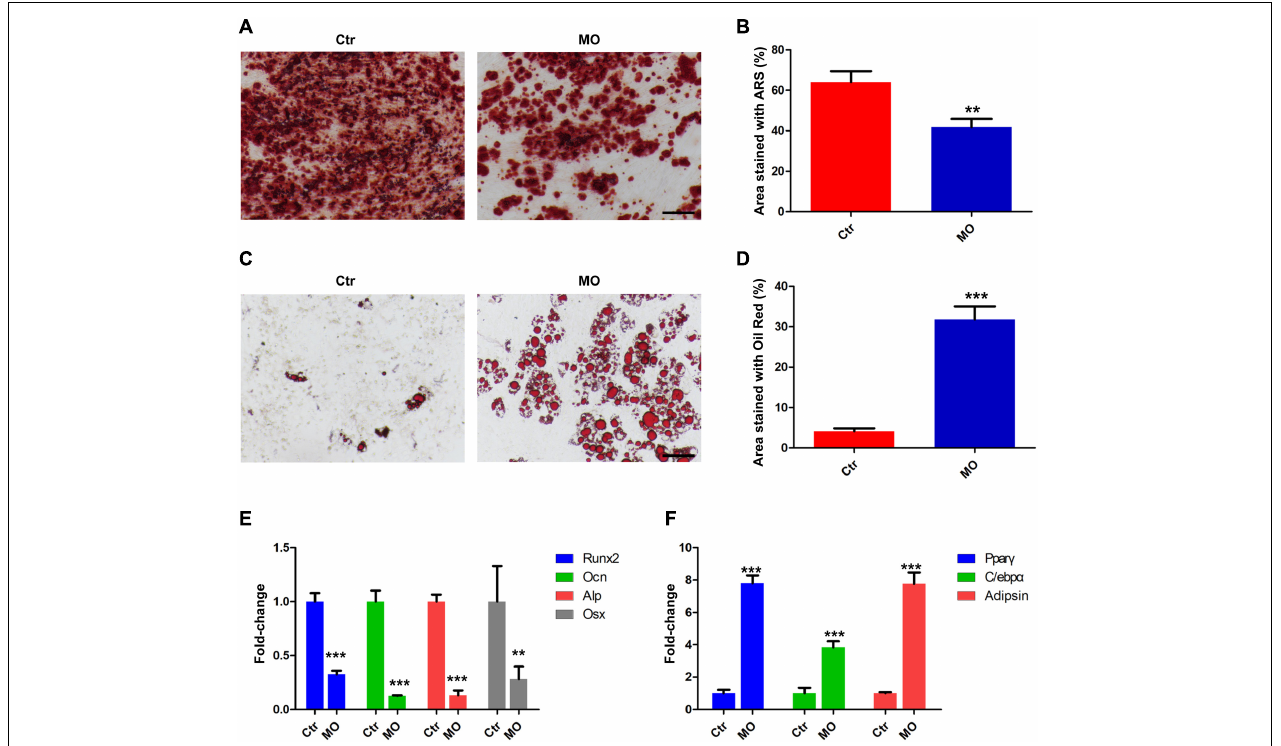
FIGURE 2 | The effects of INTS7 on osteoblast and adipocyte differentiation in BM-MSCs. (A) Alizarin Red S dye solution was used to stain differentiated osteoblasts. (B) Quantification of the Alizarin Red S-stained areas in (A) , n = 3. (C) Oil Red O dye solution was used to stain differentiated adipocytes. (D) Quantification of the Oil Red O–stained areas in (C) , n = 3. (E) The mRNA levels of facilitated factors responsible for osteogenic differentiation were detected by QRT-PCR after INTS7 inhibition, n = 3. (F) The mRNA levels of effective molecules regulating adipocyte differentiation were detected by QRT-PCR after INTS7 inhibition, n = 3. Scale bar, 100 µ m. ** p < 0.01; *** p < 0.001, Student’s t